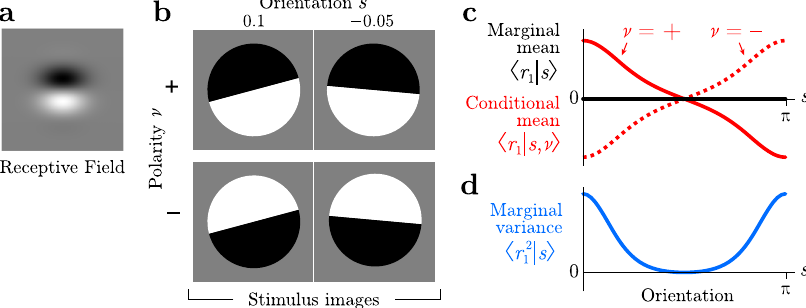
Fig. 1 Simple nonlinear code for orientation induced by two polarities. a Receptive fi eld for a linear neuron. b Four example images, each with an orientation s ∈ [0, π ) and a polarity ν ∈ { − 1, + 1}. c The mean response of the linear neuron is tuned to orientation if polarity were speci fi ed (conditional mean, red). But when the polarity is unknown and could take either value, the mean response is untuned (marginal mean, black). d Tuning is recovered by the marginal variance even if the polarity is unknown